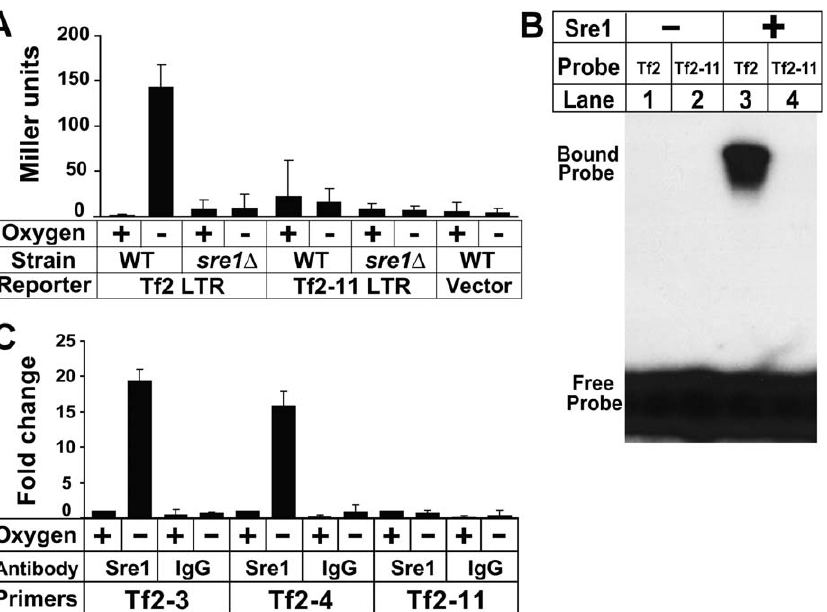
Figure 3. Tf2 LTR Is an Oxygen-Dependent Promoter (A) Wild-type and sre1 D yeast carrying Tf2 LTR- lacZ , Tf2–11 LTR- lacZ , or lacZ reporter plasmids were grown þ / (cid:2) oxygen for 6 h and assayed for b - galactosidase activity [26]. Error bars denote one standard deviation among three biological replicates. (B) Sre1 DNA binding domain (aa 256–366) was incubated with indicated 32 P-labeled DNA probes and subjected to electrophoretic mobility shift assay [26]. (C) Wild-type yeast were grown þ / (cid:2) oxygen for 6 h and subjected to chromatin immunoprecipitation using anti-Sre1 IgG or rabbit IgG. Bound DNA was normalized to wild type þ oxygen for each primer pair. The fraction of bound DNA values for the pulldown with anti-Sre1 under aerobic conditions were 0.0027 (Tf2–3), 0.003 (Tf2–4), and 0.017 (Tf2–11). Error bars denote one standard deviation among three experimental replicates.